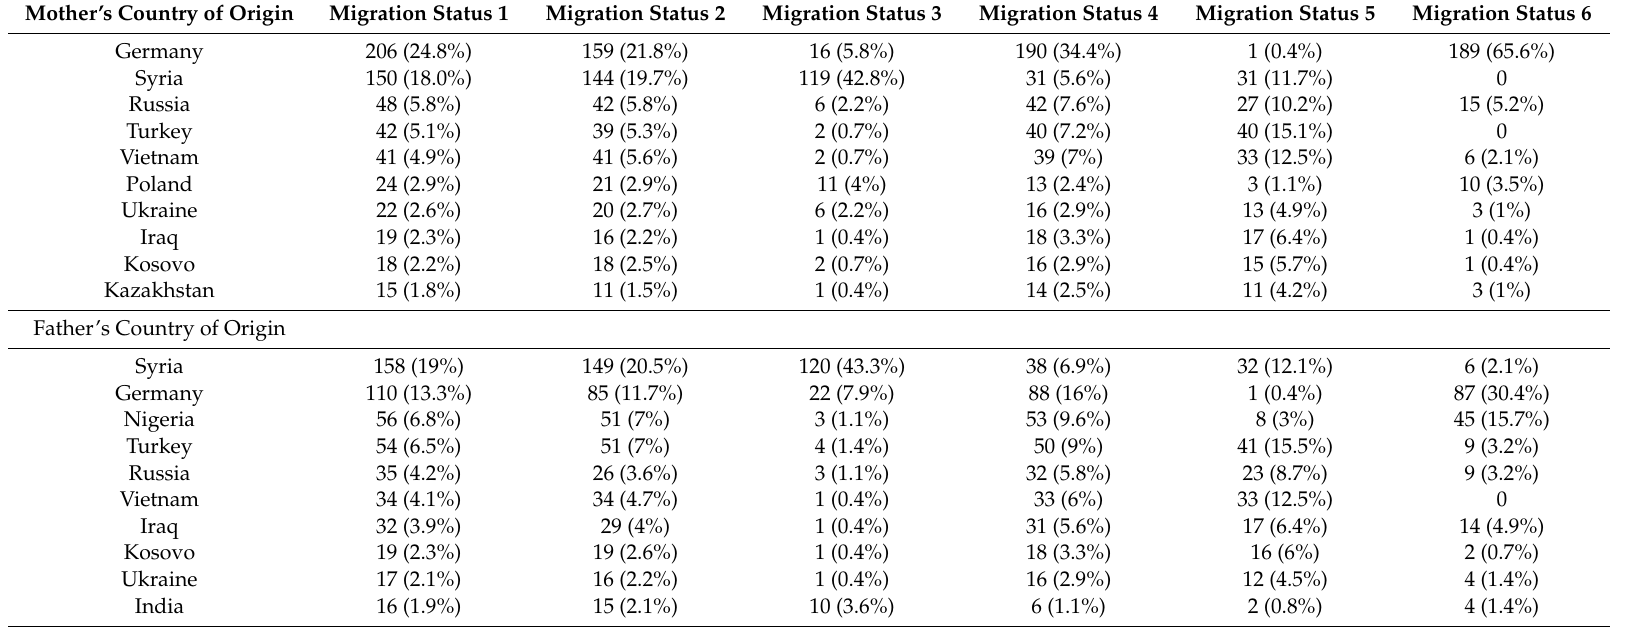
Table 2. Parents’ country of